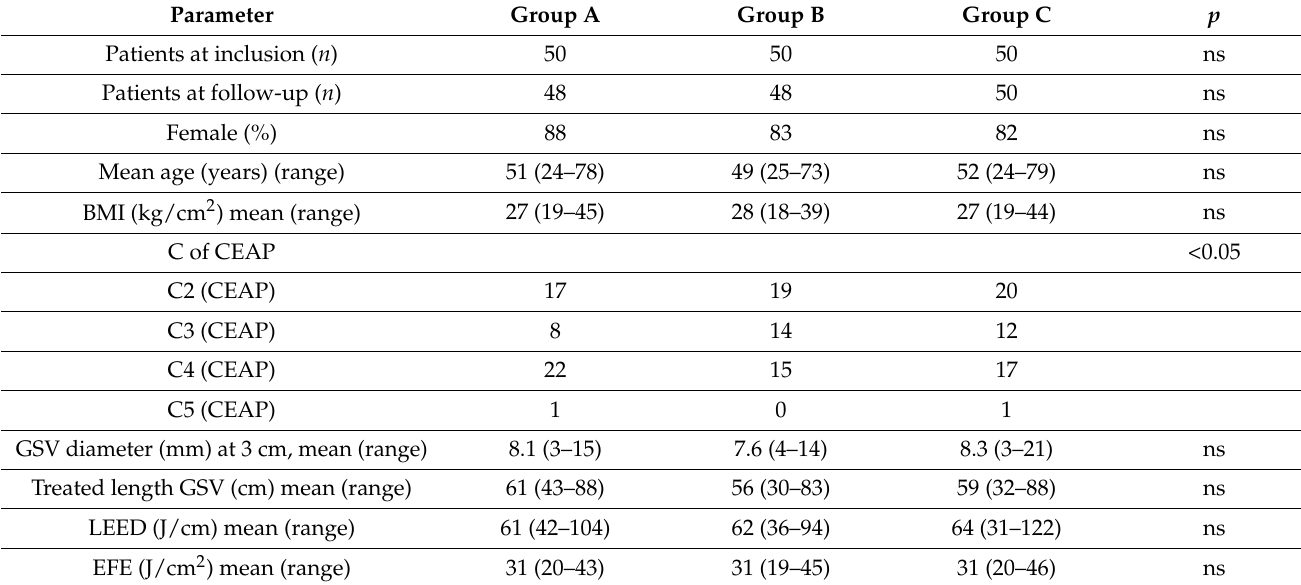
Table 1. Patients’ general and technical treatment data (GSV = great saphenous vein, n = number, BMI = body mass index, C = clinical class CEAP classification, LEED = linear endovenous energy density, EFE = endovenous fluence equivalent, p = p -value, ns = difference not significant).